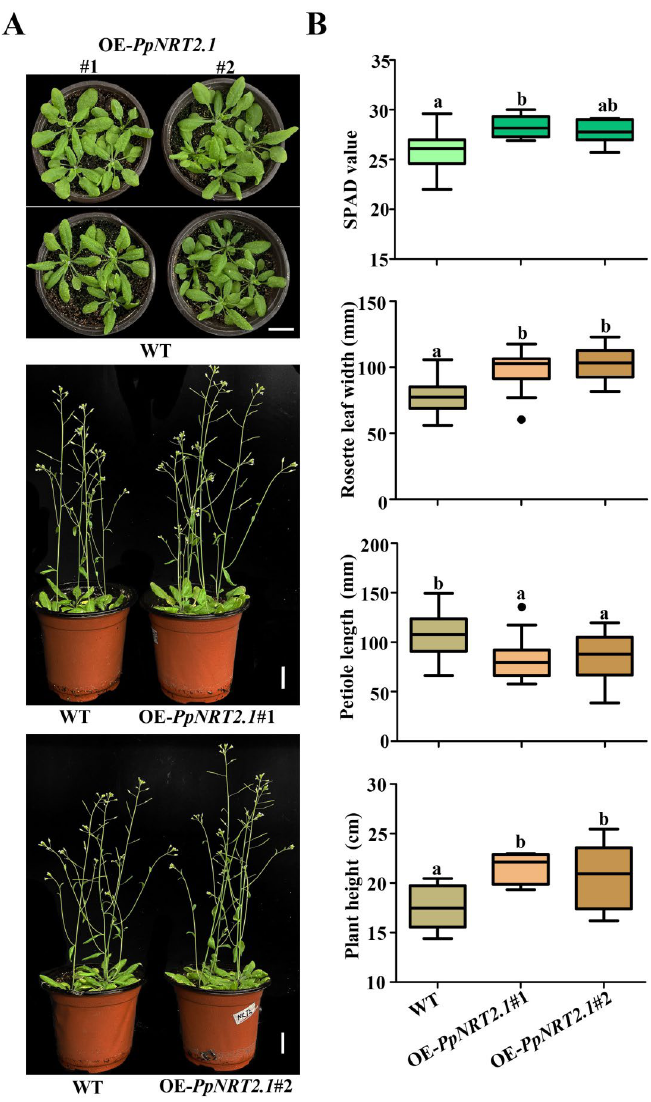
Figure 9. Morphology of Arabidopsis plants with different genotype. ( A ) Photographs of representative plants growing in artificial vegetative soil. Scale bar: 2 cm. ( B ) Comparison of OE- PpNRT2.1 and WT leaf SPAD, leaf width, petiole length and plant height. Black dots represent outliers. At least 5 statistical values of the indicators for each genotype ( n ≥ 5 ). Different lowercase letters indicate significant differences at p < 0.05 by one-way ANOVA with Duncan (D)’s multiple comparisons